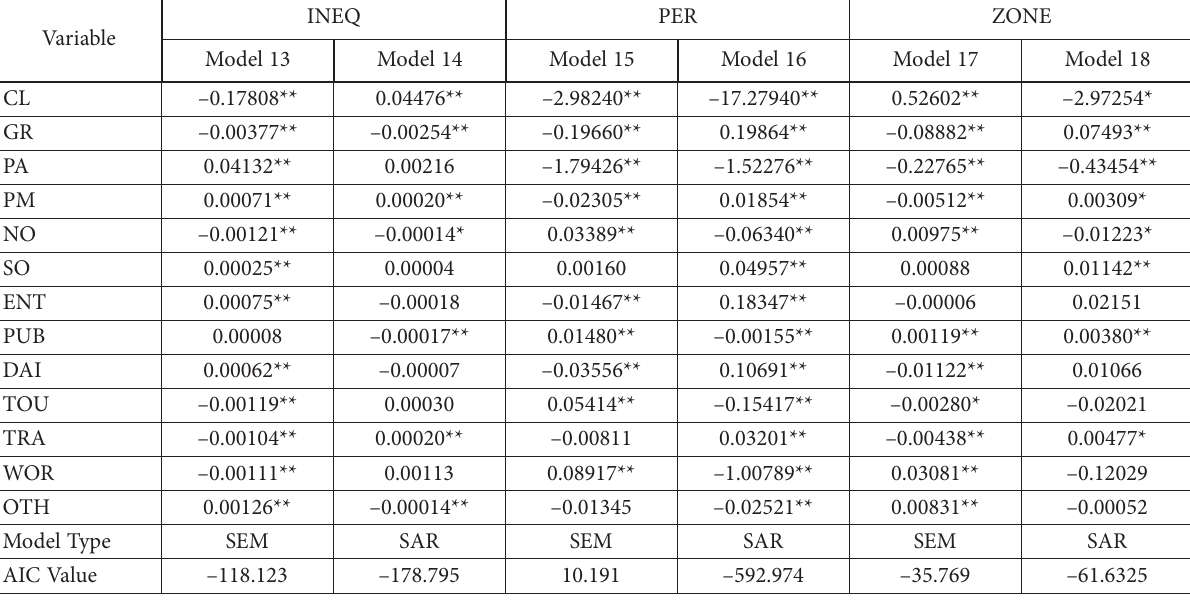
Table 7. Parameter estimation result of local regression models in regions with different topographical conditions